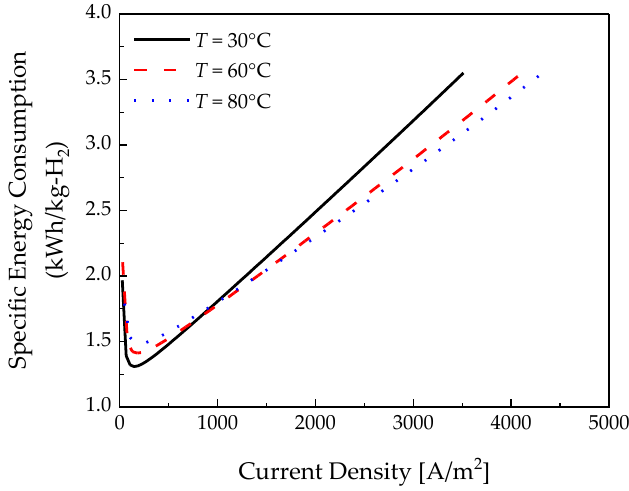
Figure 8. Specific energy consumption with respect to temperature.